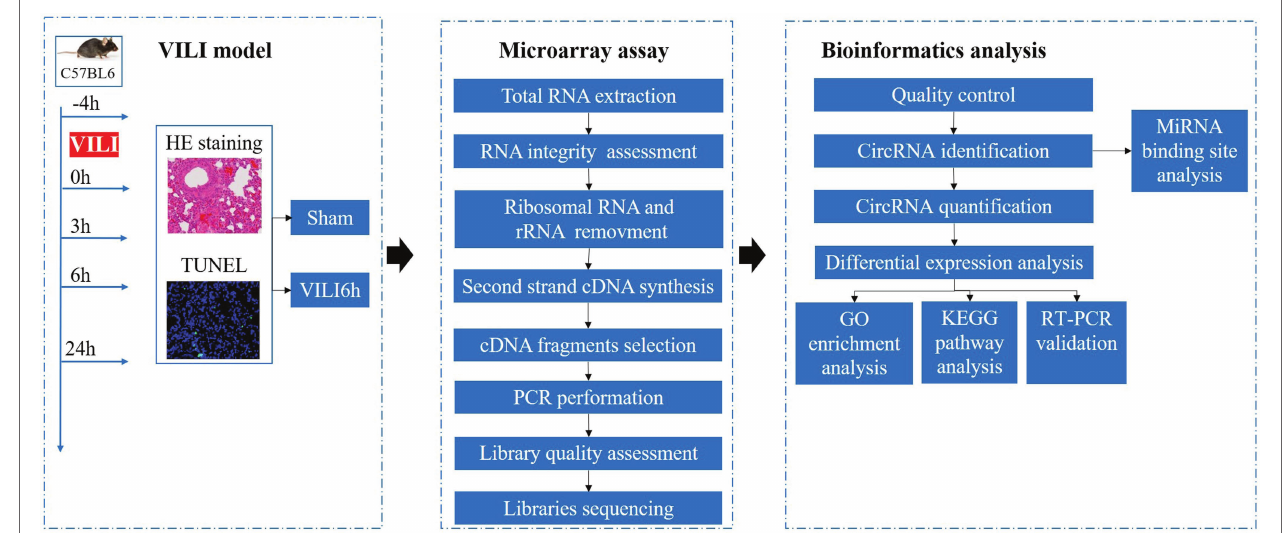
FIGURE 1 | Analytical procedures used in this